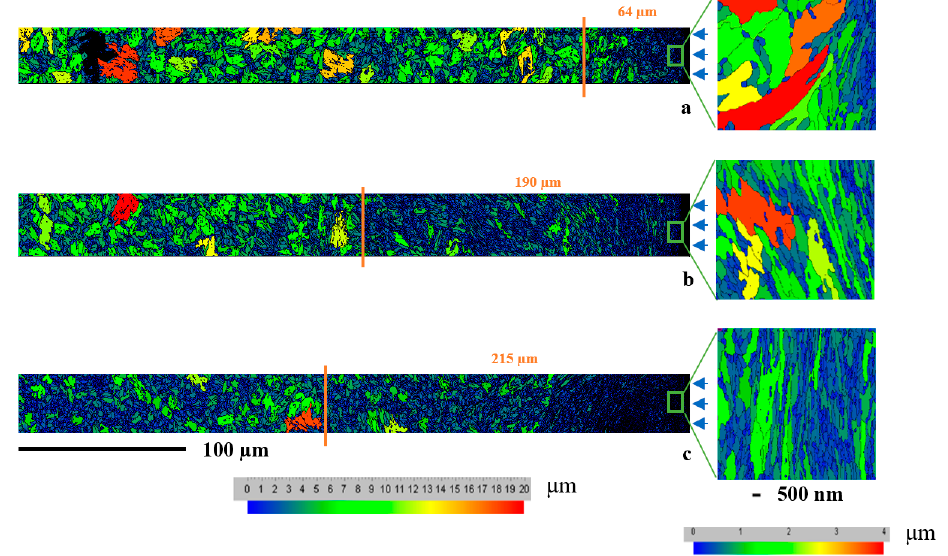
Figure 2. Grain size evolution in shot peened samples with a misorientation of >15°, a scan area of 400 × 30 µm 2 , and a step size of 200 nm. The inset is corresponding to an 8 × 6 µm area scanned with a step size of 25 nm. The arrows are indicating the shot peening direction. ( a ) CSP, ( b ) SSP5, and ( c ) SSP10. Table 3. Grain size distribution of treated sample surfaces calculated from the inset images of Figure 2. Average Grain Size Serie Coverage (%)